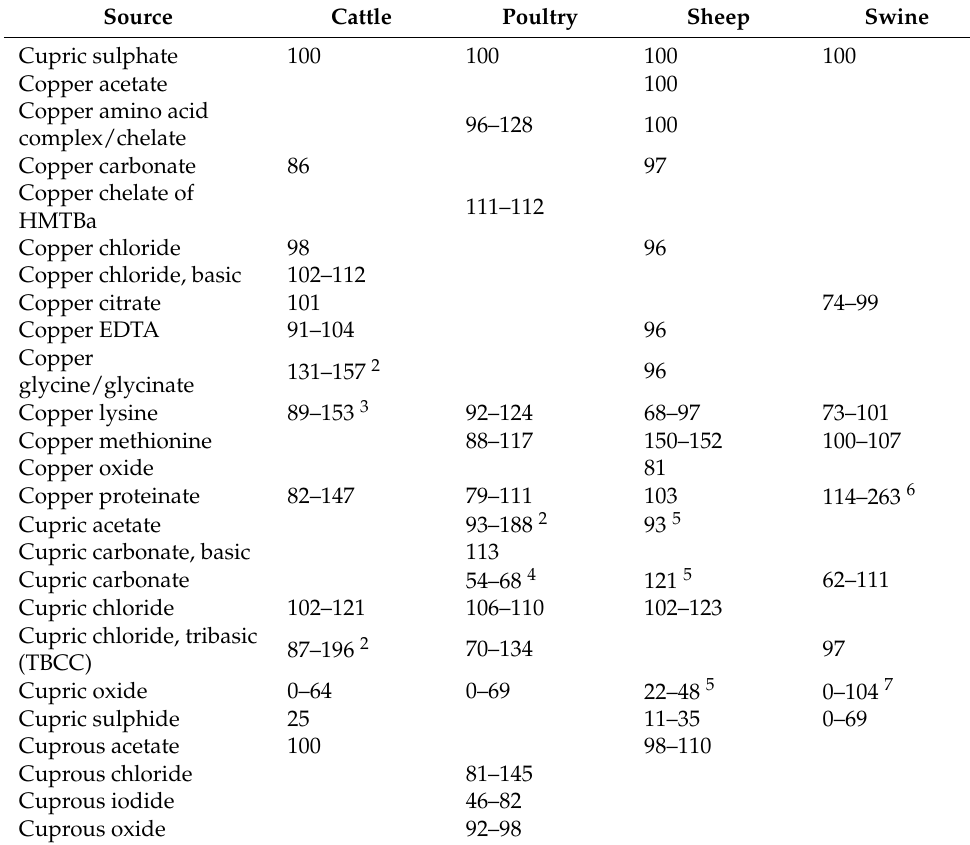
Table 4. Multi-species table of relative bioavailability values (%) for copper 1,8 .